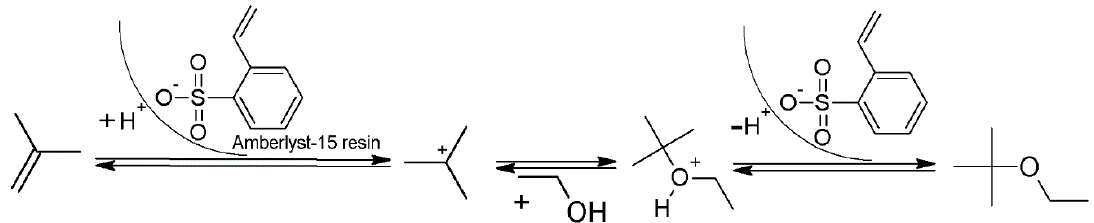
Figure 1. Proposed mechanism of isobutylene activation and conversion via carbenium-ion mechanism at Amberlyst-15 (sulfonic groups at the catalyst resin).